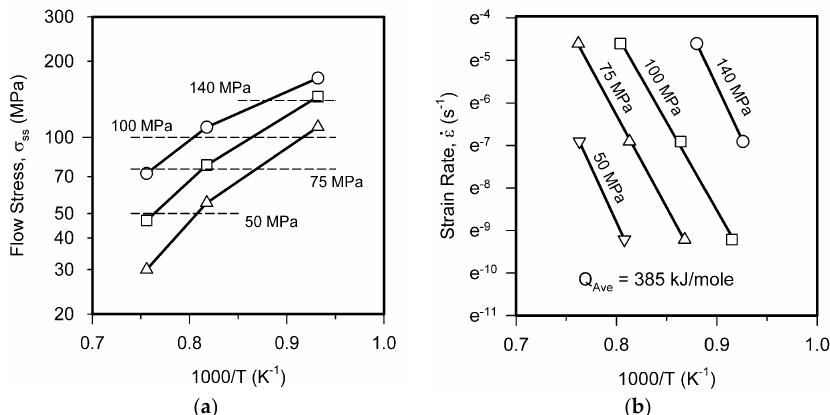
Figure 2. The temperature effect on the steady-state flow stress ( a ) or strain rate ( b ) upon hot compression of a high-Mn steel.